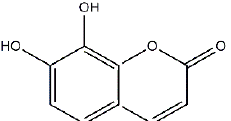
Figure 1. Structure of daphnetin (Molecular Weight 178.143 g/mol).